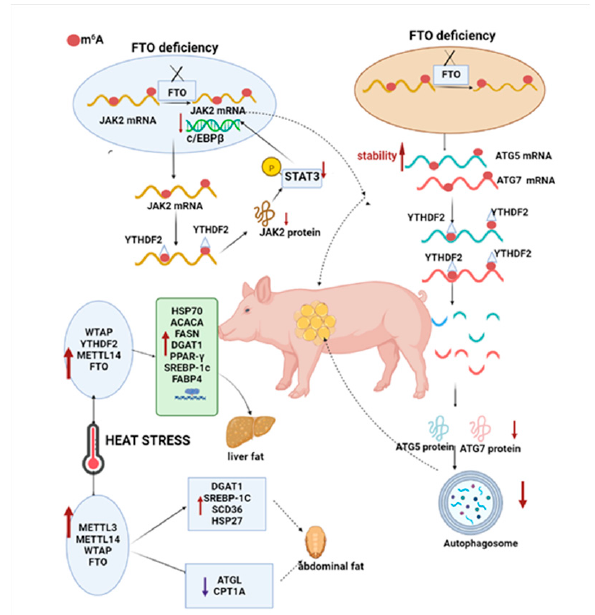
Figure 8. Regulation mechanism of pig lipid metabolism by m 6 A. The figure shows the part of the regulation of m 6 A on pig lipid metabolism. FTO plays an important role in the early stages of porcine adipogenesis, as FTO deletion inhibits JAK2 m6A demethylation modification and thus increases JAK2 mRNA stability YTHDF2 is in-volved in mediating m6A-dependent JAK2 mRNA stability, thereby reducing JAK2 expression and consequently STAT3 phosphorylation levels, making translocation to the nucleus more difficult and thus inhibits the transcription of C/EBP β , a transcription factor essential for early adipogenesis.In porcine precursor adipocytes, knockdown of the demethylase FTO increased the level of m6A modification of the autophagy-related genes ATG5 and ATG7 and thus enhanced mRNA stability, which was then recognized and degraded by YTHDF2, resulting in a significant decrease in ATG5 and ATG7 protein expression, inhibiting autophagosome formation and autophagic flow, and ul-timately fat deposition.